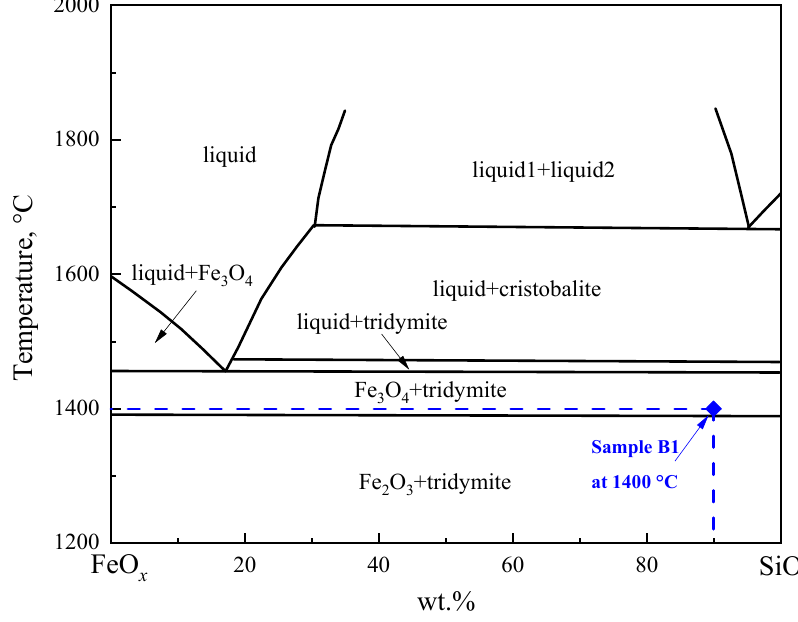
Figure 4. The SiO 2 -FeO x binary phase diagram in air [42].